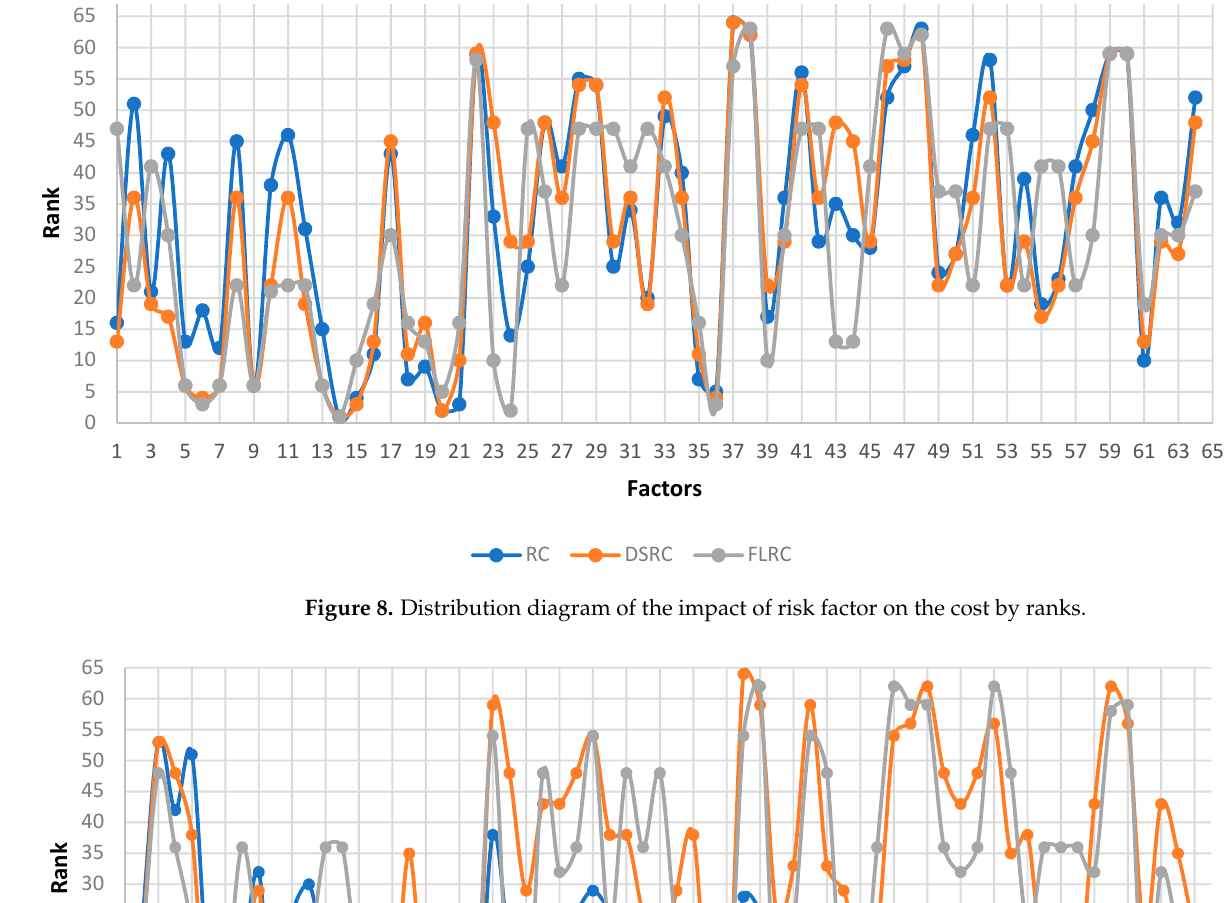
43 P—probability; IoC—impact on cost; IoT—impact on timeline; RC—risk cost; RT—risk of timeline;